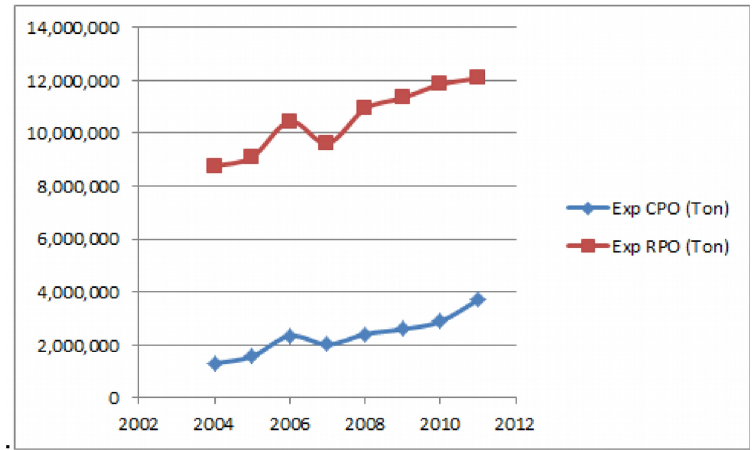
Figure 3. Malaysian CPO and RPO exports during